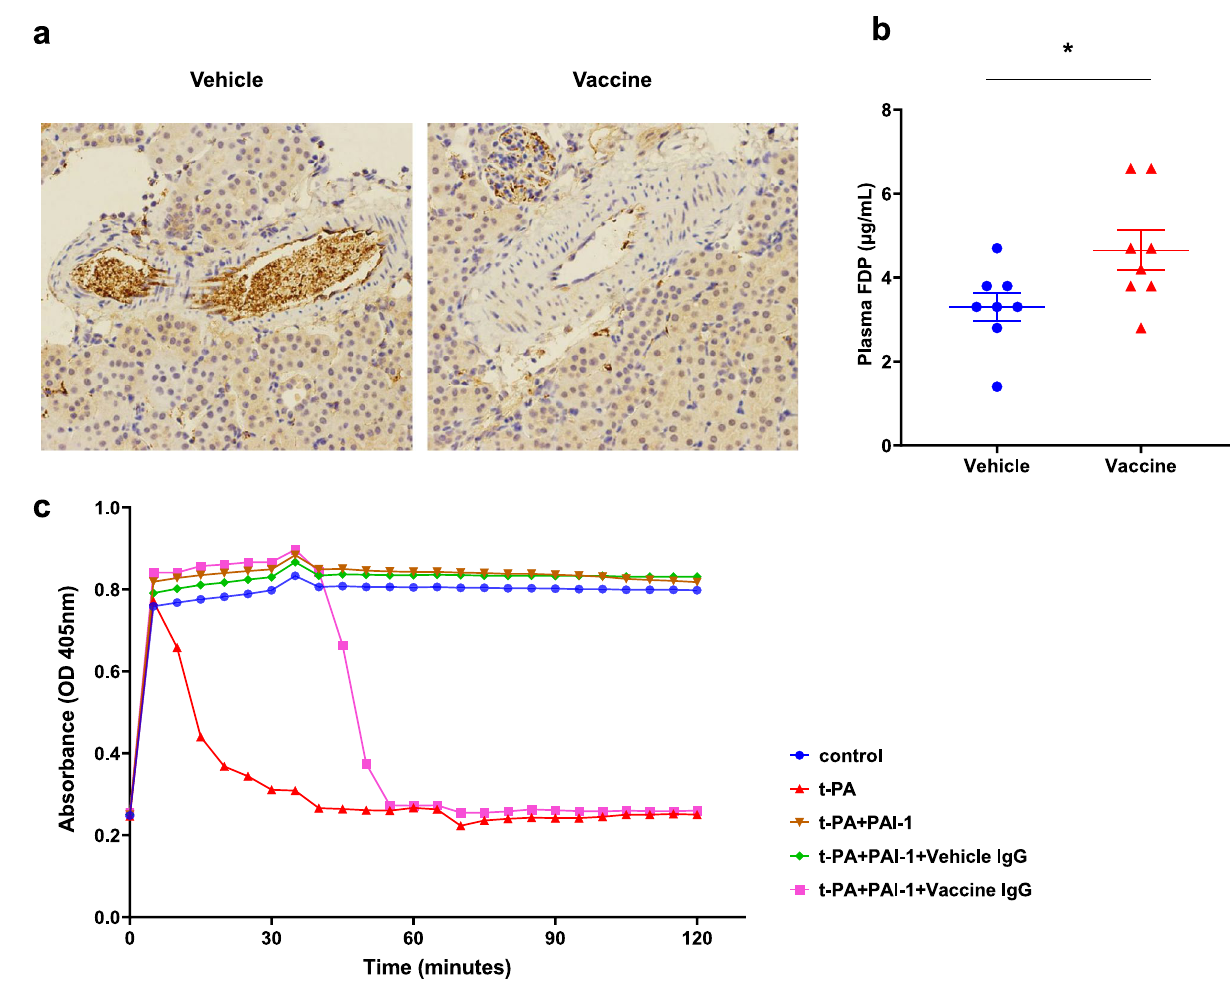
Figure 4. Fibrinolytic functions of PAI-1 vaccine in a mouse model of LPS-induced sepsis and plasma clot assay. Mice ( n = 8 per group) were immunized with PAI-1 vaccine or KLH vehicle and challenged with 6 mg/ kg LPS; kidney and plasma samples were obtained 24 h after LPS injection. ( a ) Kidney sections were stained with anti-fibrinogen antibody, and ( b ) plasma fibrin degradation products were measured. Data are expressed as mean ± SEM (error bars). Statistical difference between vaccine and vehicle groups with LPS challenge was determined by using Student’s t -test. * P < 0.05 compared with the value for the vehicle-treated group. ( c ) The following six arms were established in the plasma clot lysis assay: control (normal human plasma + assay buffer + human thrombin + CaCl 2 ), control + t-PA, control + tPA + PAI-1, control + tPA + PAI-1 + KLH vehicle- elicited IgG, and control + tPA + PAI-1 + PAI-1 vaccine-elicited IgG. Clot lysis was observed for 120